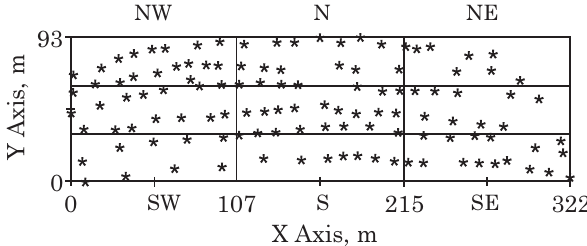
Figure 1. Diagram of the experimental geostatistical